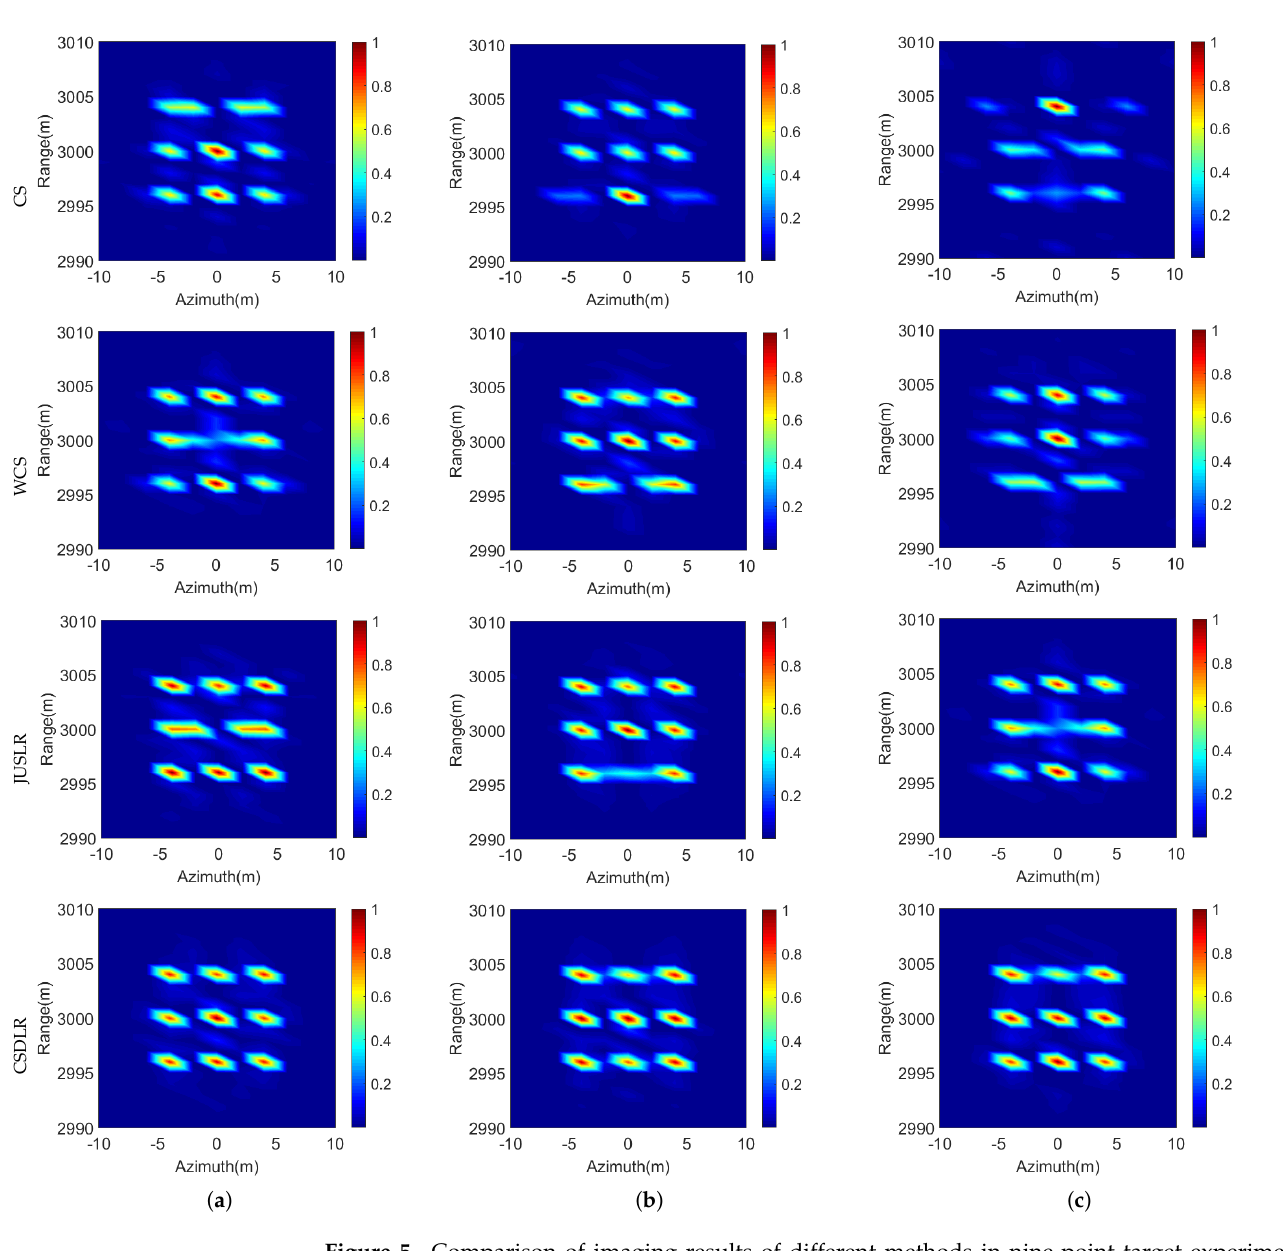
Figure 5. Comparison of imaging results of different methods in nine-point target experiment.